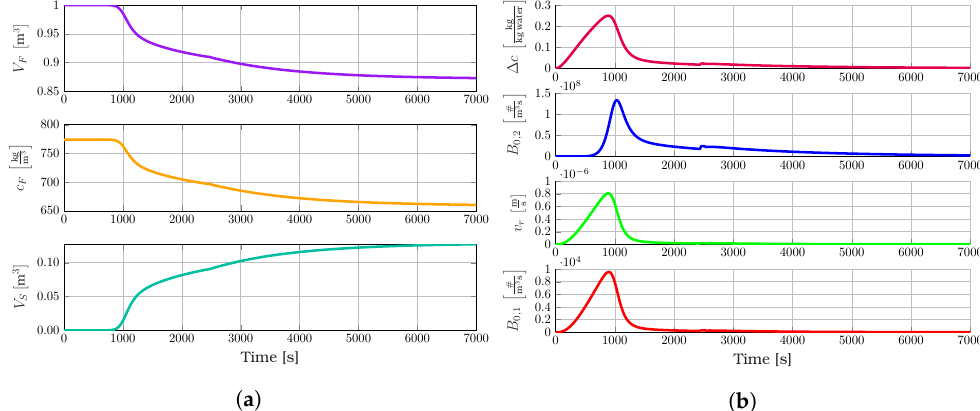
Figure 6. ( a ) The change in V F , c F and V S over time; ( b ) the change in ∆ c , B 0,2 , v r , B 0,1 in the case of the non-isothermal batch system.